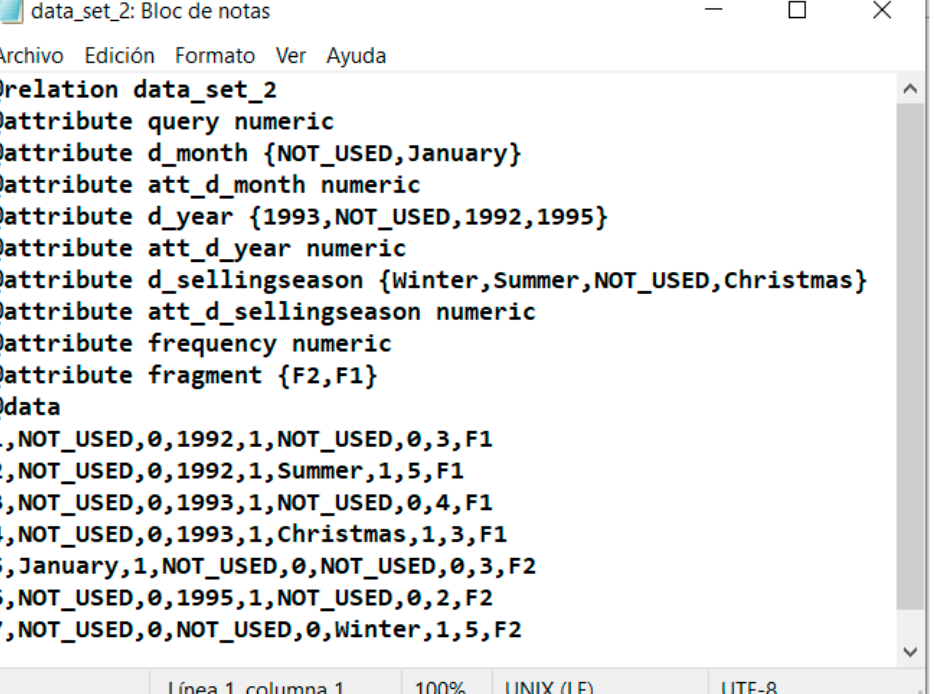
1,577,160 Table 6. Partition Tree for the scenario. Step